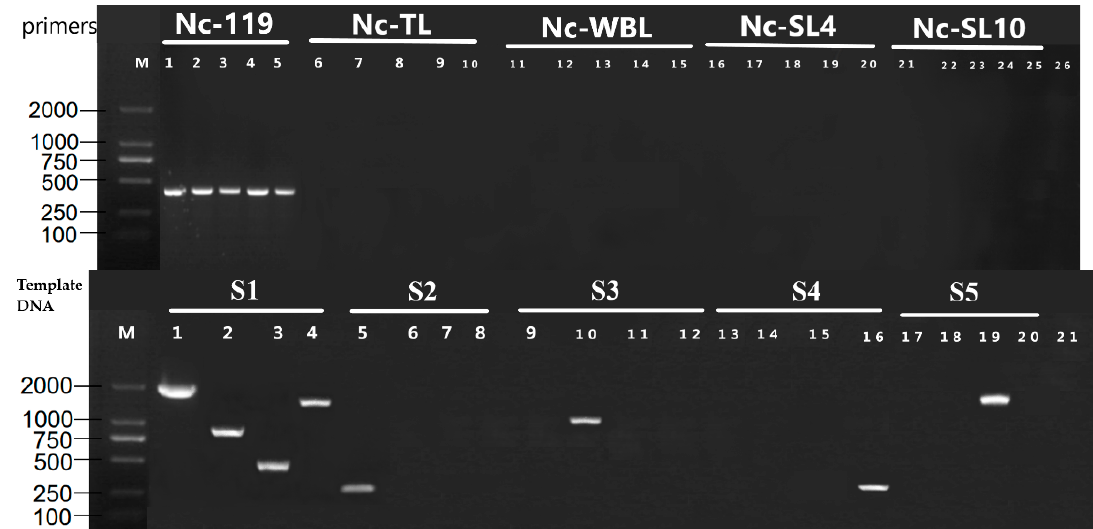
Figure 2. The PCR amplification of isonuclear alloplasmic strain S1–S5 nuclei and mitochondrion DNA. ( A ) The PCR amplification of strain S1–S5 nuclear genome. M indicates the 2000 bp DNA marker; the primers of lanes 1–5, 6–10, 11–15, 16–20, and 21–25 were Nc-119, Nc-TL, Nc-WBL, Nc-SL4, and Nc-SL10, separately; the template DNA of lane 1, 6, 11, 16, and 21 was S1; the template DNA